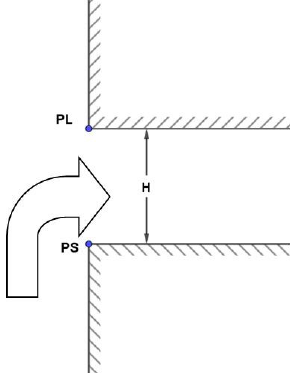
Figure 2. Examples of different types of entrances.